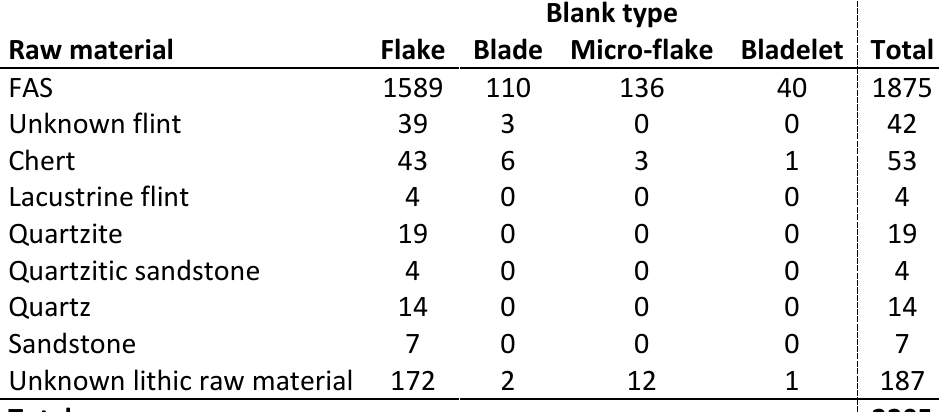
Table 9. Blanks from GH 3.